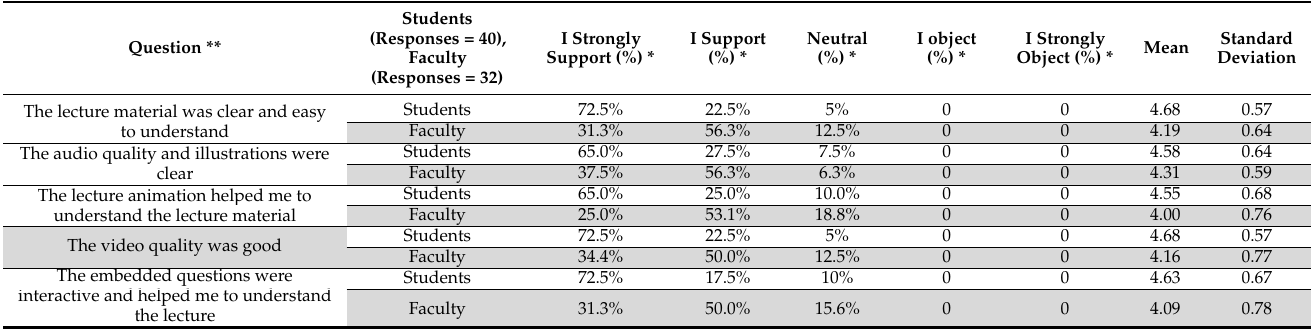
Table 2. Students’ and faculty members’ perceptions on the five quality attributes of the interactive e-lecture.